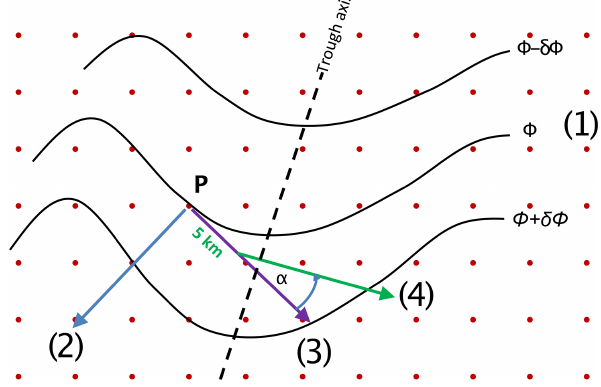
Figure 2. Schematic showing the different steps in determining the local curvature of the geopotential height isolines. The steps are as follows: (1) geopotential height isolines (black contours) at ev- ery grid value (red points), (2) local gradient vector (blue) of the geopotential height at a specific grid point P , (3) 90 ◦ rotated vector (purple) to get a tangent vector parallel to the geopotential height isolines, (4) a 5km step along the geopotential height isolines in the direction of vector (3) and a new tangent vector (green) derived at the new position, and (5) calculating the angle α between the vec- tors labeled (3) and (4). For further details, see the